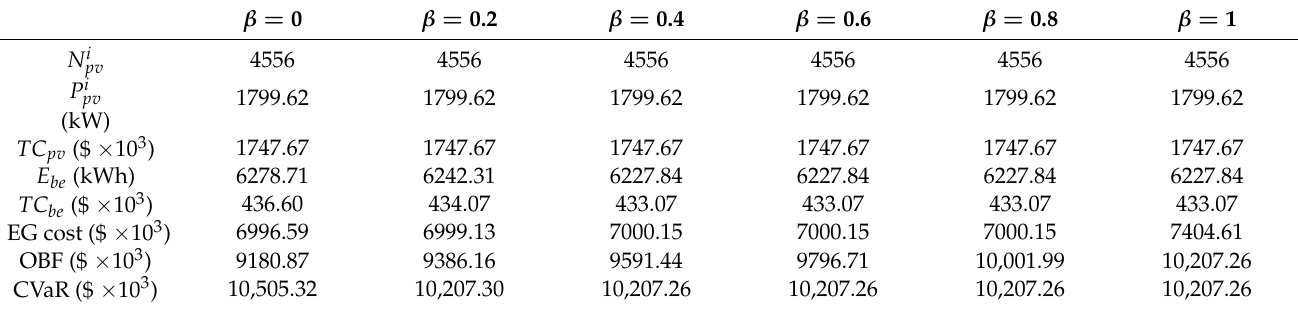
Table 13. Results for the cost that makes the battery viable in adverse hydrological